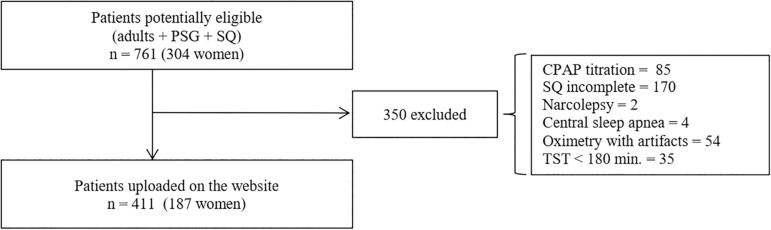
Flow chart for patient selection (PSG = Polysomnography; SQ = Sleep Questionnaires; TST = Total Sleep Time).